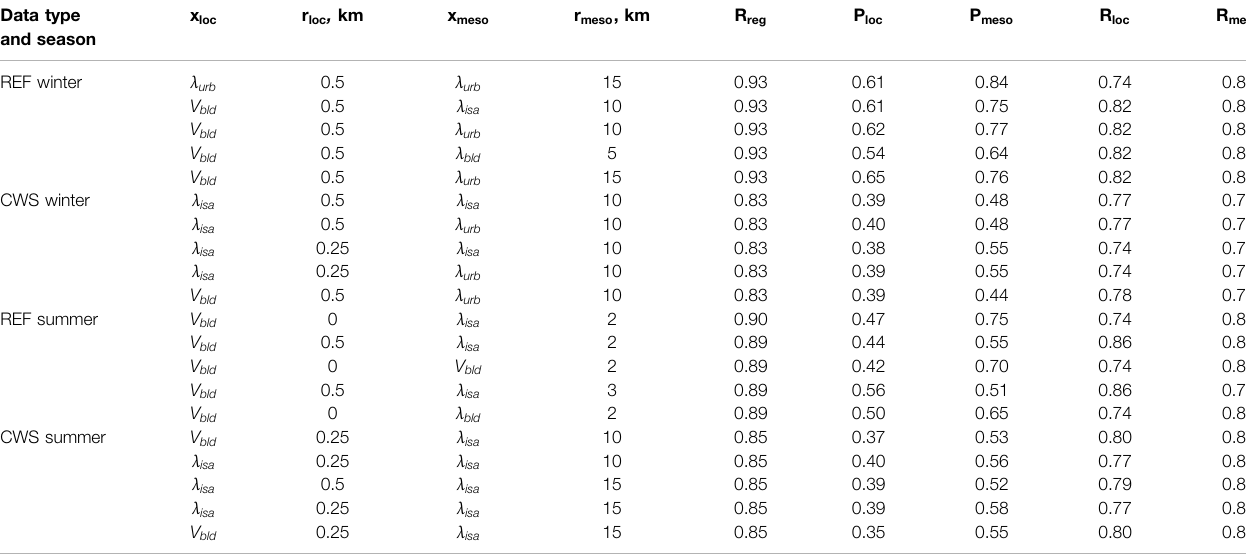
TABLE 1 | Results of the multiple linear regression predicting of the summer and winter urban heat island (UHI) intensity based on reference network (REF) and citizen weather station (CWS)